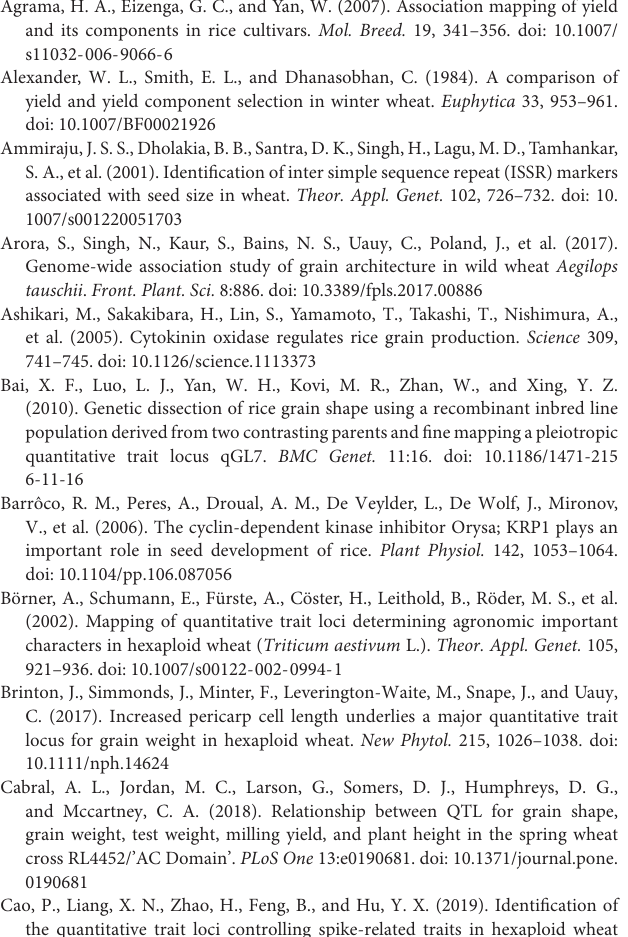
Supplementary Table 7 | Analyses of variance for kernel-related traits.